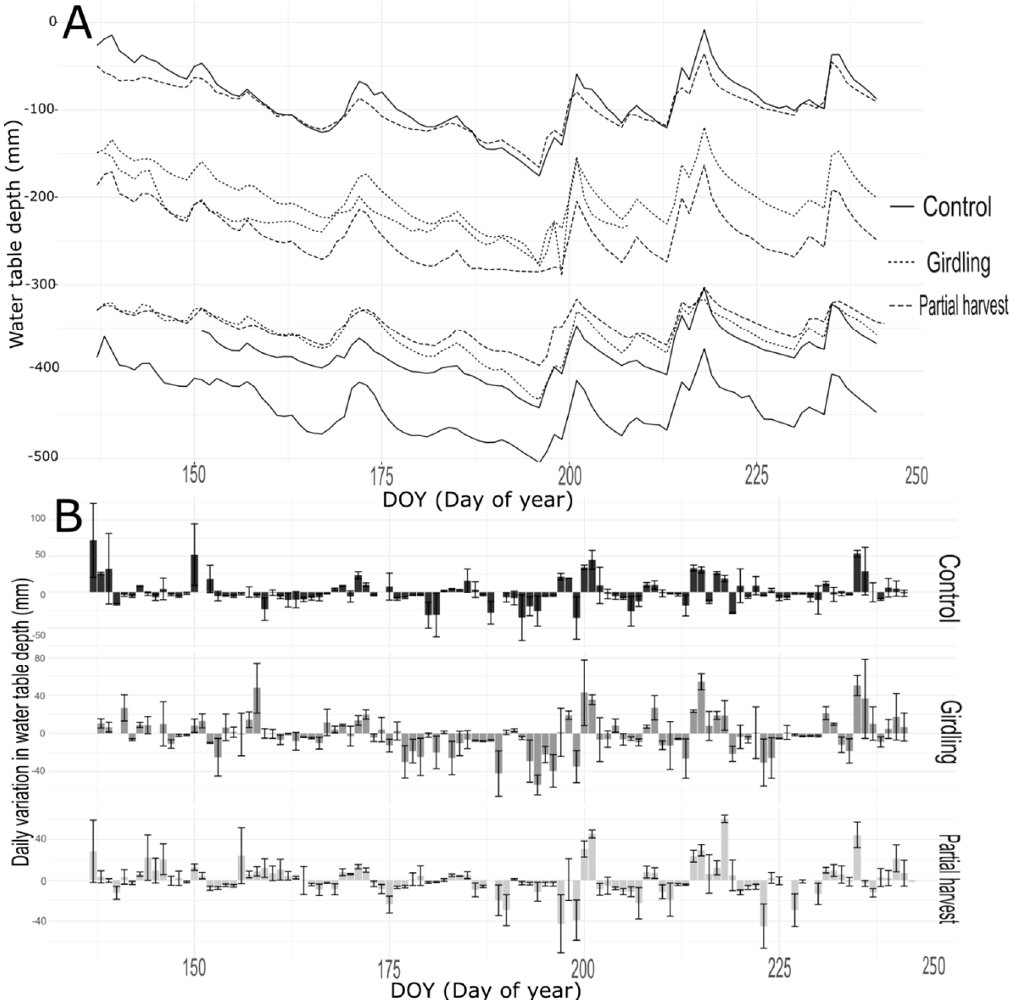
Figure 5. Water table movement throughout the growing seasons of 2017, after the sylvicultural treatments. ( A ) water table depth of each plot according to treatment. ( B ) Mean daily variation in water table depth with standard error (mean ± SE) throughout the growing seasons of 2017, after the sylvicultural treatments. Each daily variation in water depth is a mean based on water table depth of three different plots for each treatment. The missing data for the water table depth are due to technical problems.